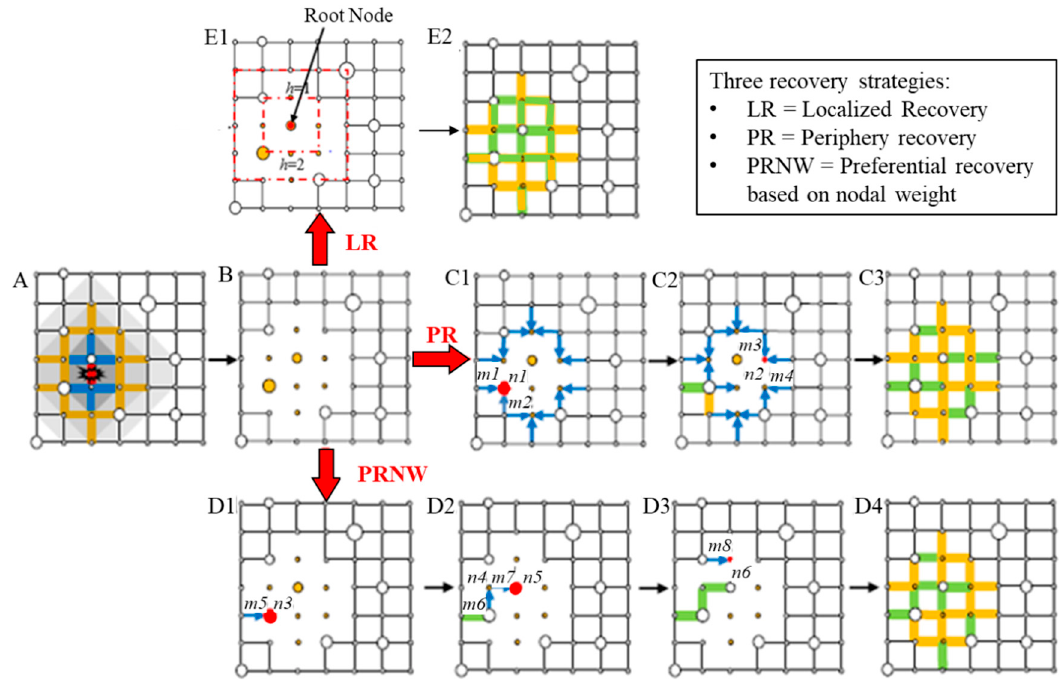
Figure 2. The illustration of various strategic repair processes after a localized attack on a two-dimensional square lattice network with heterogeneously populated nodes